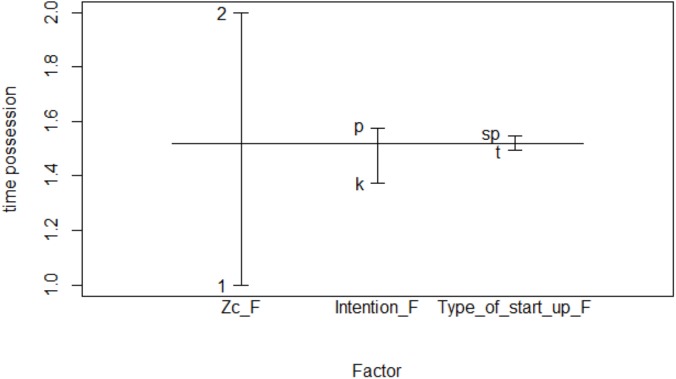
Main effects in successful teams.